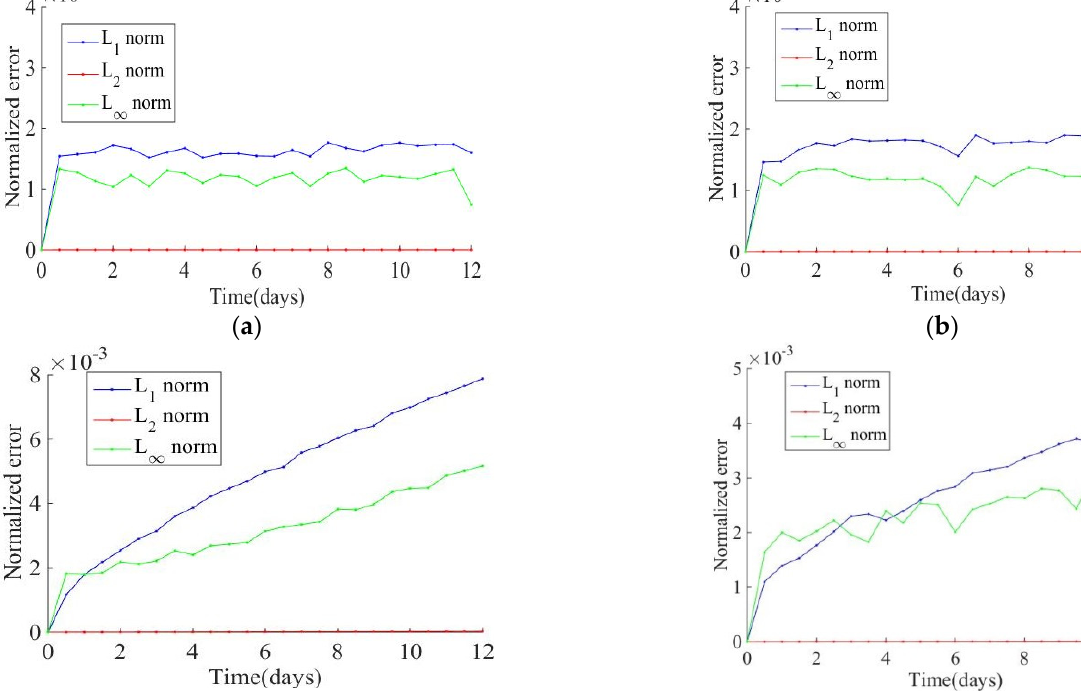
Figure 8. The L 1 , L 2 and L ∞ norm error for the cosine bell test case as a function of time on the icosahedron sphere triangle mesh with refinement level 5, Advection of the height field around the sphere once. Results are for the global RBF method and local RBF method with dt = 12 h. Gauss kernel function was used. ( a ) Global RBF and the wind direction angle α = 0; ( b ) global RBF and the wind direction angle α = π /2; ( c ) local RBF and the wind direction angle α = 0; ( d ) local RBF and the wind direction angle α = π